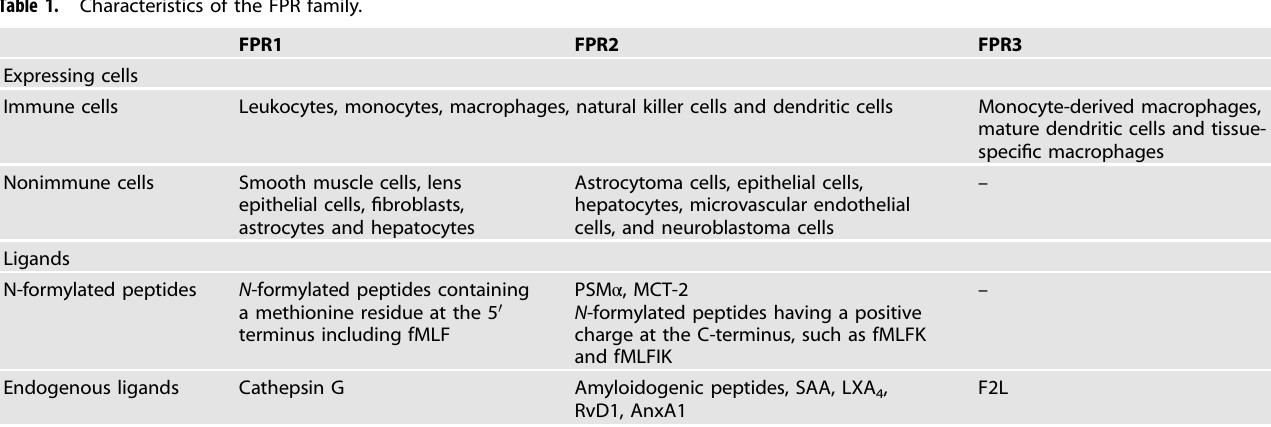
Table 1. Characteristics of the FPR